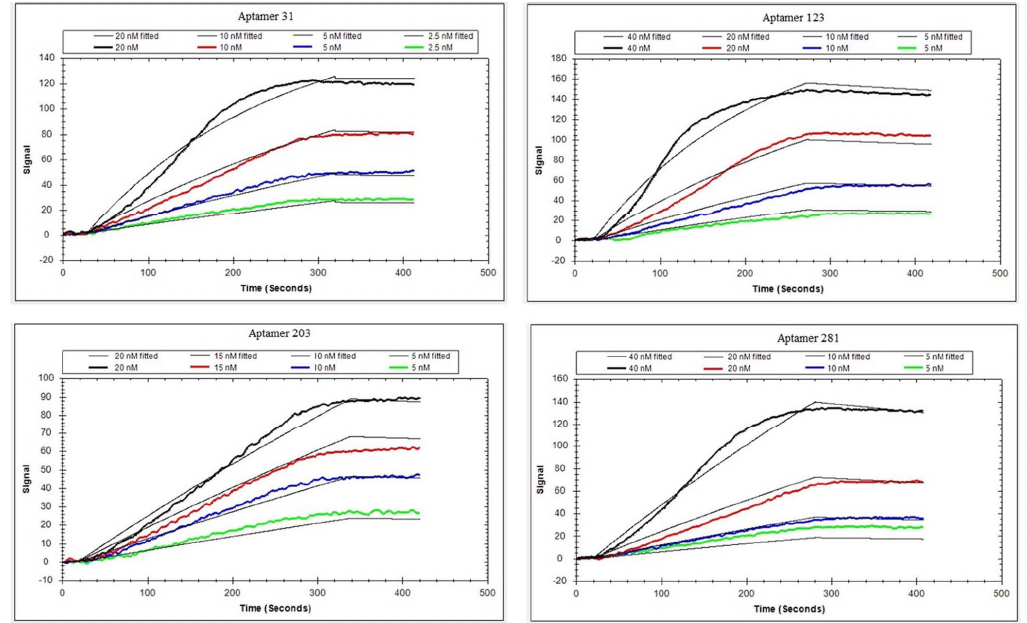
Figure 3. Binding kinetic curve of four aptamers interacting with di(2-ethylhexyl) phthalate (DEHP) by localized surface plasmon resonance (LSPR) assay.